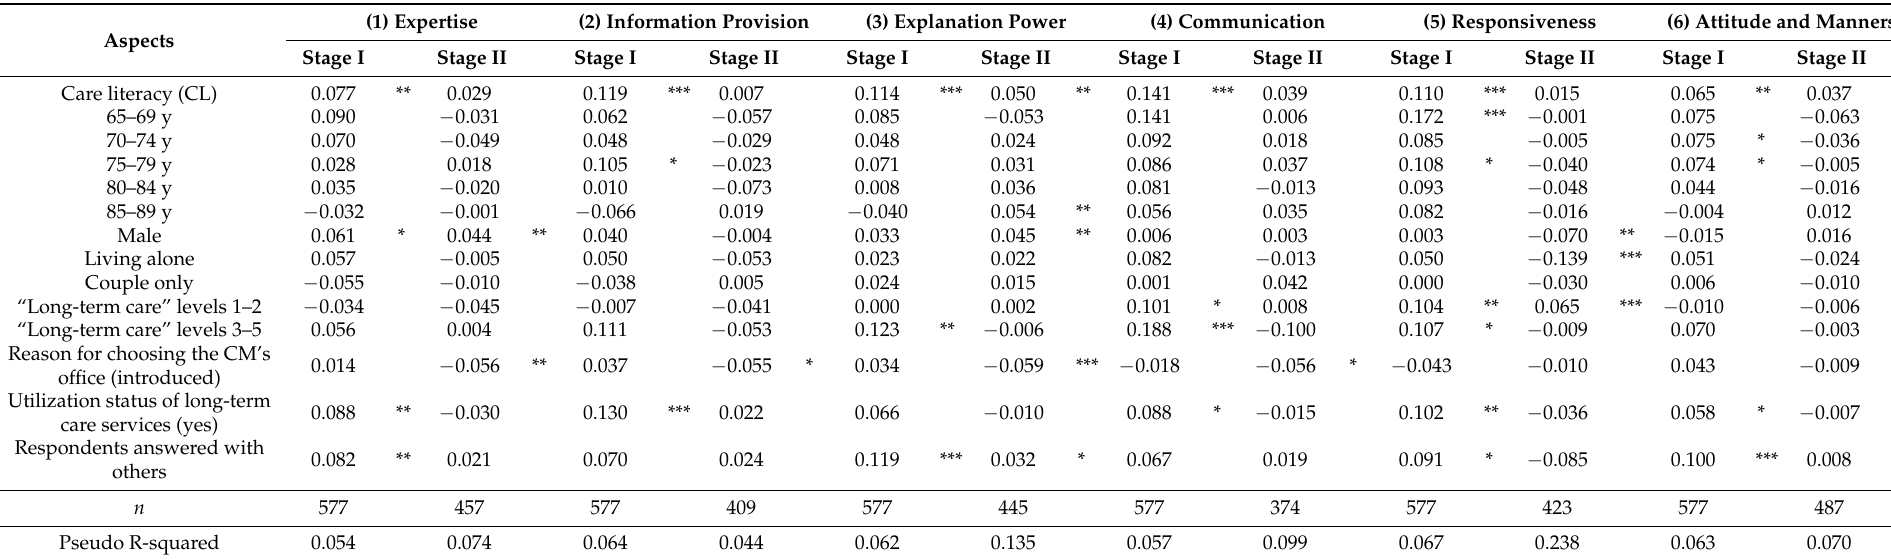
Table 5. Marginal effects of CL and other covariates on satisfaction with CMs estimated by inverse probability